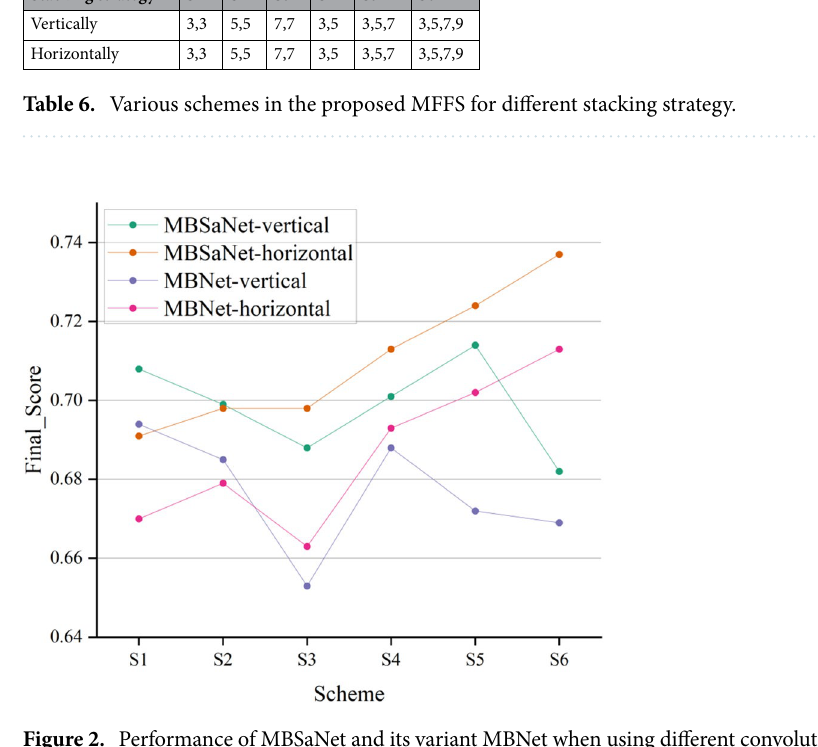
Figure 2. Performance of MBSaNet and its variant MBNet when using different convolution stacking strategies in the feature extraction stem